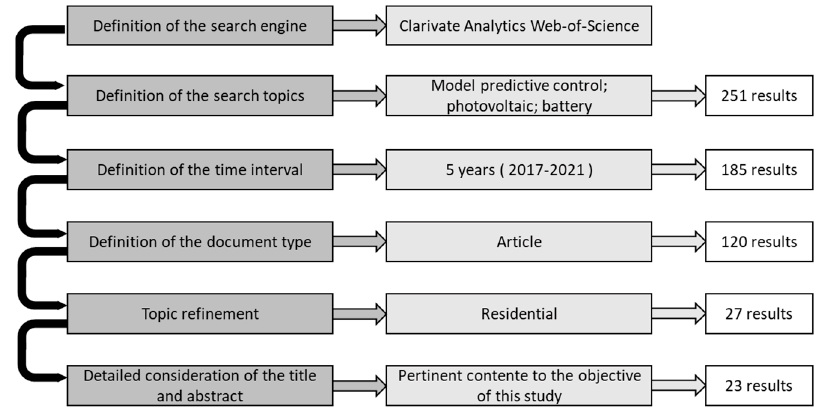
Figure 1. Survey rationale for the review of the related